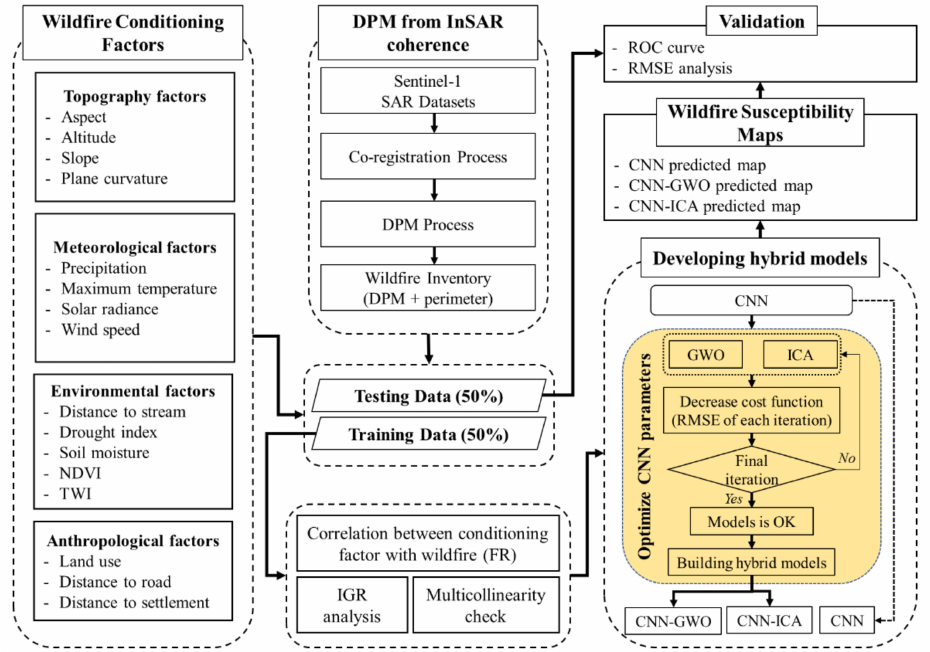
Figure 1. Flowchart of the overall